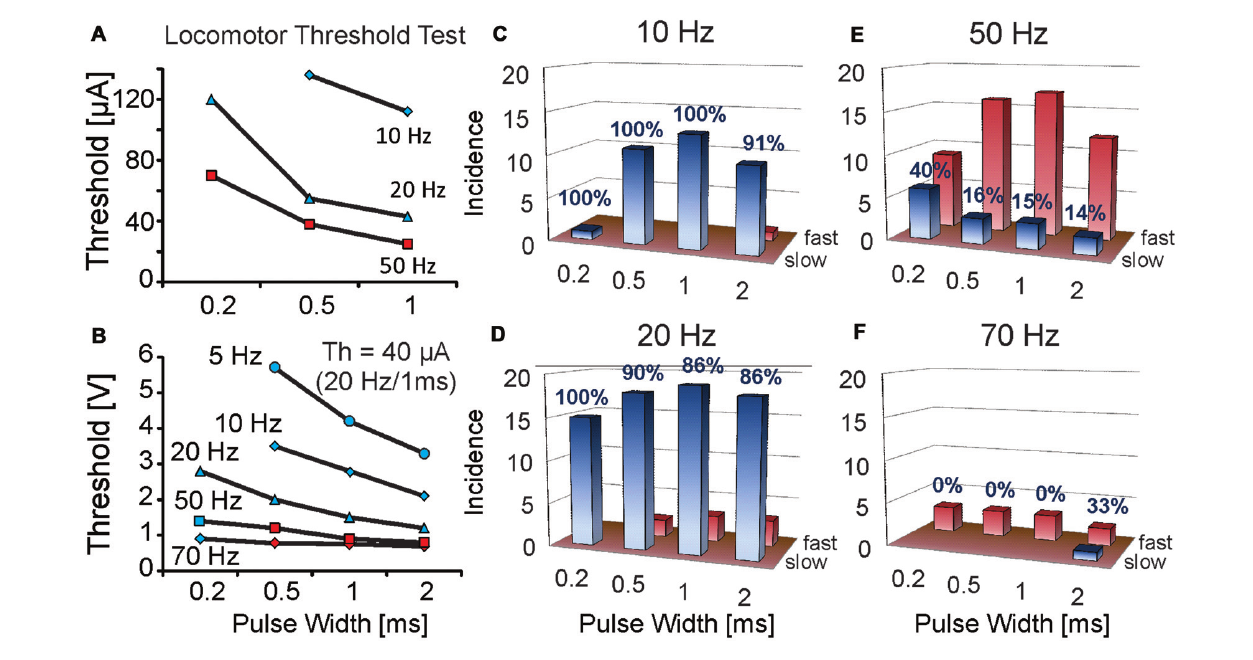
FIGURE 2 | Rate of locomotion at threshold strengths for initiating locomotion varies with different stimulation frequencies and pulse widths. Locomotor threshold parameter tests for single MLR stimulation sites were conducted at various stimulus frequencies and pulse widths. (A,B) Thresholds plotted relative to pulse width and frequency for two animals; one intact (A) and one with mid-thoracic moderate contusion injury (B) . Current threshold (Th) for the spinal cord injury (SCI) animal at 20 Hz, 1 ms duration was 40 µ A. Note that greater strengths of stimulation were required with lower frequencies and shorter pulse widths. Initial locomotor responses vary according to frequency and pulse width of stimulation: stimulation frequencies of 20 Hz typically produce slow locomotion at threshold (blue symbols) in contrast to higher stimulation frequencies which typically initiate fast locomotion at threshold (red symbols). (C–F) Incidence of slow or fast locomotion at threshold strengths for initiating locomotion for different stimulation frequencies and pulse widths in uninjured animals 1 week after electrode implant. Note higher incidence of slow locomotion (percentage indicated) at low stimulation frequencies (10 and 20 Hz) vs. high frequencies (50 and 70 Hz). The number of trials is indicated on the ordinate (1 trial per animal). Red bars indicate the incidence of fast locomotion, while the blue bars indicate the incidence of slow locomotion. Only one data point per animal is included for each frequency and pulse width test combination. A similar response was observed during threshold tests in the SCI animal (B)